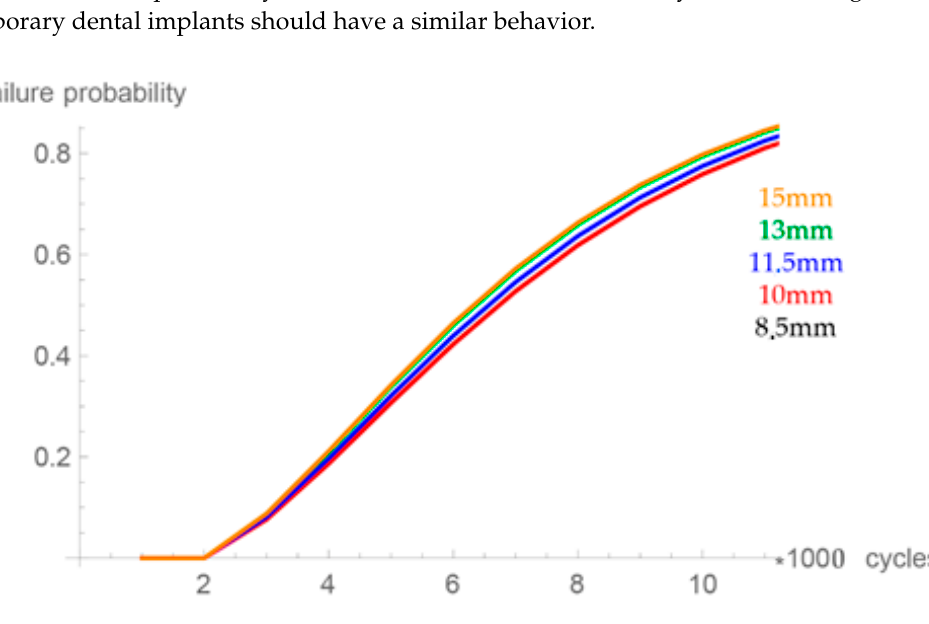
Figure 6. Graphs that relate the probability of failure with the number of cycles.